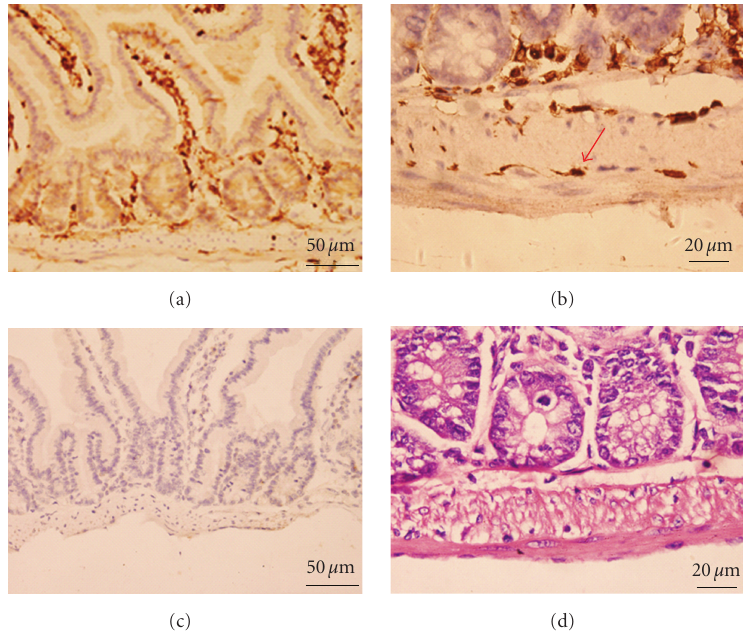
Figure 2: Detection of donor-derived BMDCs by GFP IHC in the small intestine 3 months after transplantation. (a) GFP positive BMDCs could be integrated into any part of intestine. (b) donor-derived cells could also be observed between longitudinal muscle and circular muscle, and there were some positive processes without ICCs body due to section reason (red arrow). (c) blank control without primary antibody on the serial section. No positive signals could be detected. (d) HE staining of small intestine from transplanted